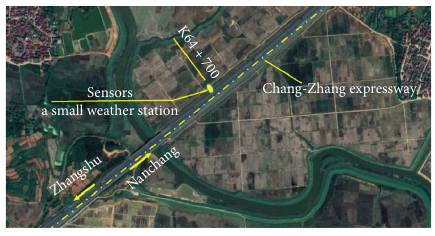
Figure 1: Field measurement